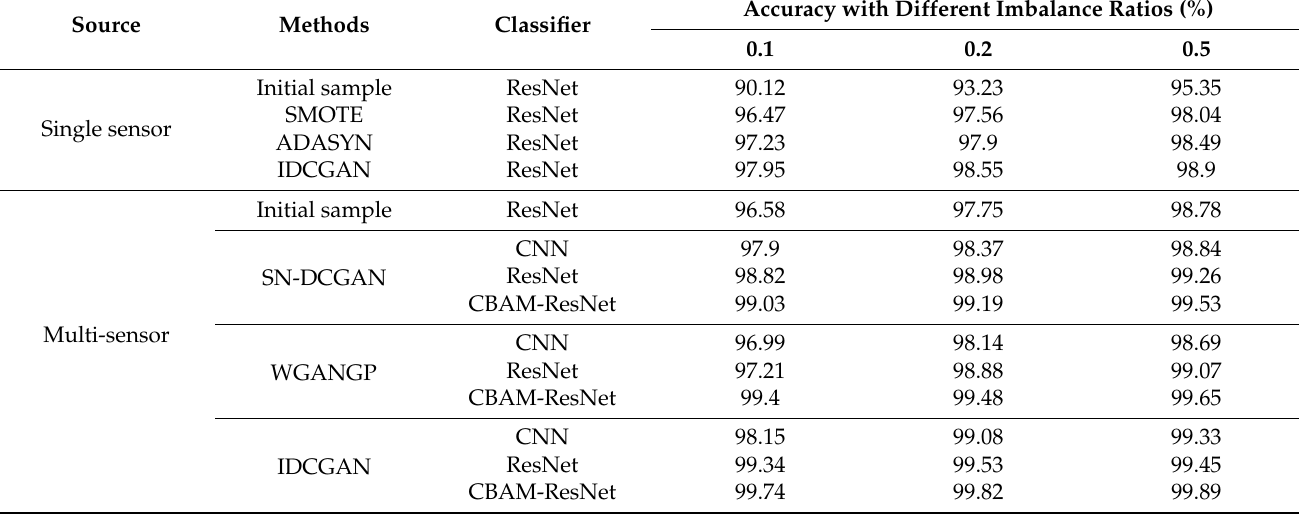
Table 7. Results after data augmentation of IRF with different initial imbalance